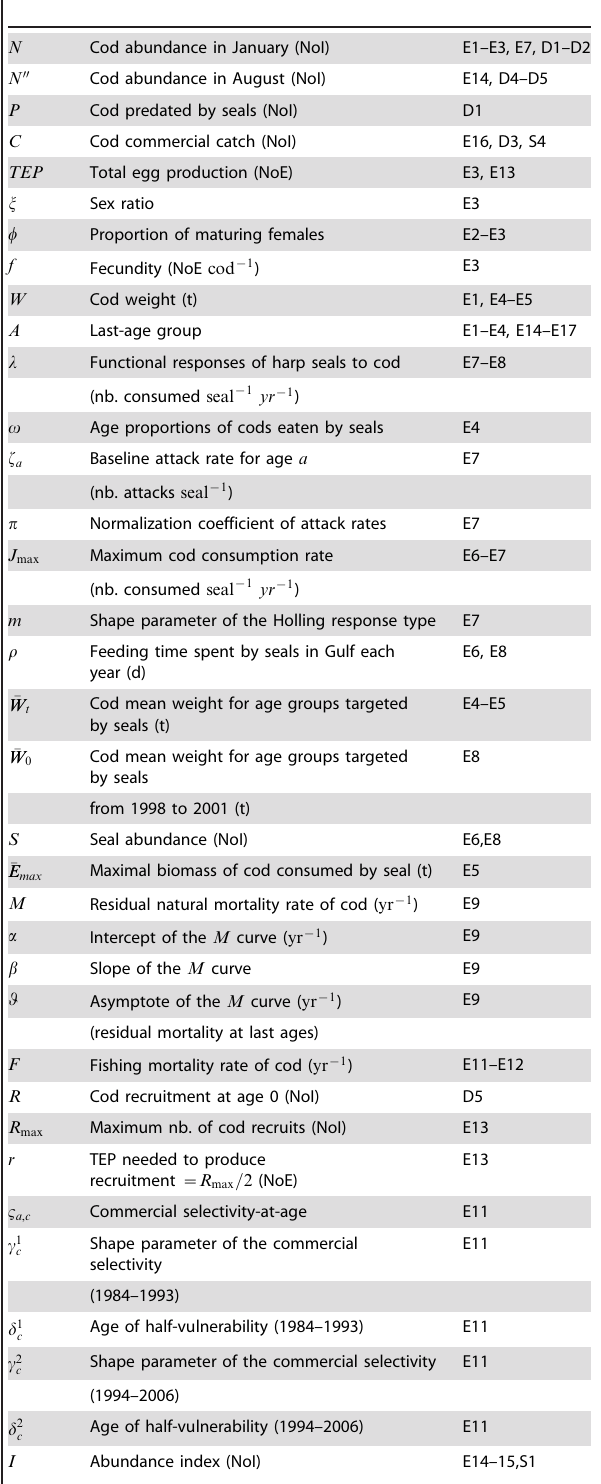
Table 1. Parameters, variables and associated equations used in the SIMCAB estimation model. a and t index age and year, respectively. NoI: number of individuals; NoE: number of eggs; ‘‘Age of half-vulnerability’’ indicates the age at which 50% of the individuals are vulnerable to survey and commercial gears indexed by s and c , respectively.